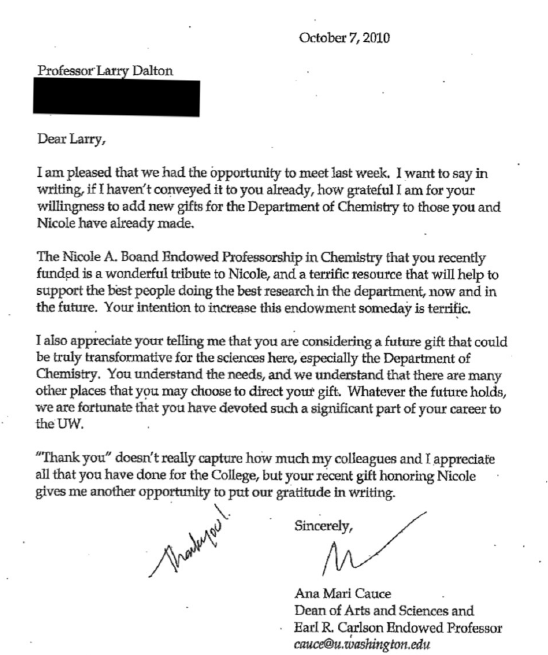
Figure 6: Memo from Dean A. M. Cauce to L. R. Dalton,